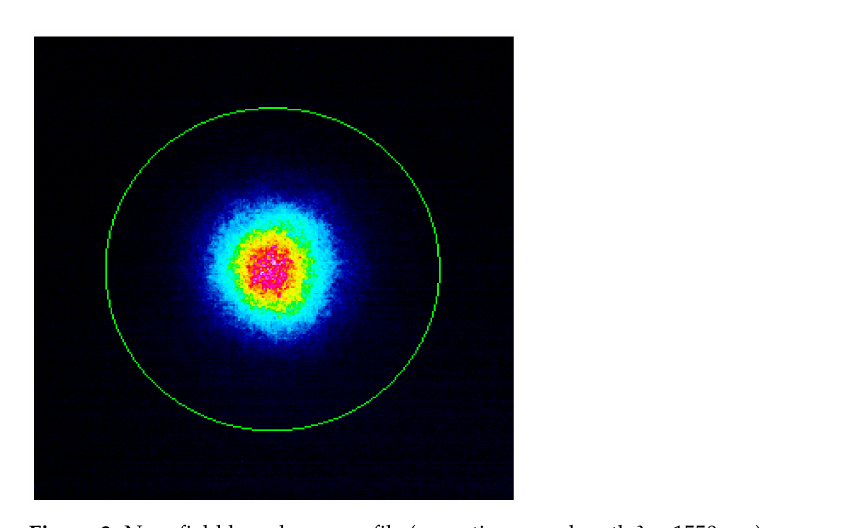
Figure 3. Near field laser beam profile (operating wavelength λ = 1550 nm), measured after propaga- tion over pilot sample of FMF 11/125 by CCD camera DataRay WinCamD-LCM-C-TE. We measured both 10 rpm and 66 rpm pilot sample 50 m length FMF 11/125 attenua- tion α ( λ ) by cutback method over wavelength band λ = 900–1700 nm by using a halogen lamp (OSRAM 64642 HLX) as a light source, programmable monochromator (ANDO), germanium photodiode (wavelength range 900. . . 1700 nm), optical amplifier (eLockIn) and optical power meter (and ANDO